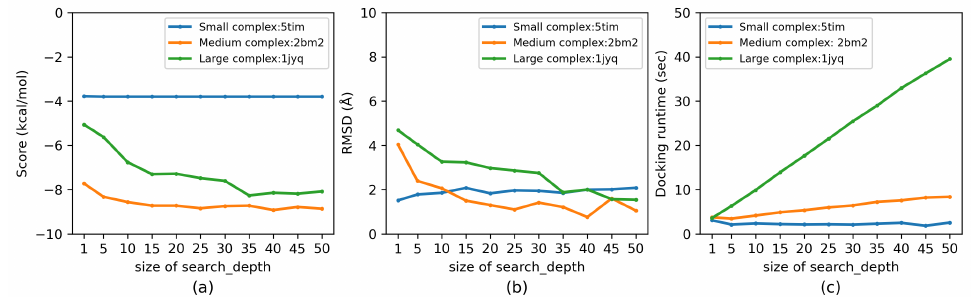
Figure 4. Influence of the size of search _ depth on docking accuracy (score and RMSD) and docking runtime of Vina-GPU in ( a ), ( b ) and ( c ), respectively. Three typical PDB complexes were randomly selected from all 140 complexes which represent small, medium and large ones, respectively (5tim— small, 5 atoms; 2bm2—medium, 33 atoms; 1jyq—large, 60 atoms). All experiments were executed on NVIDIA RTX 3090 GPU